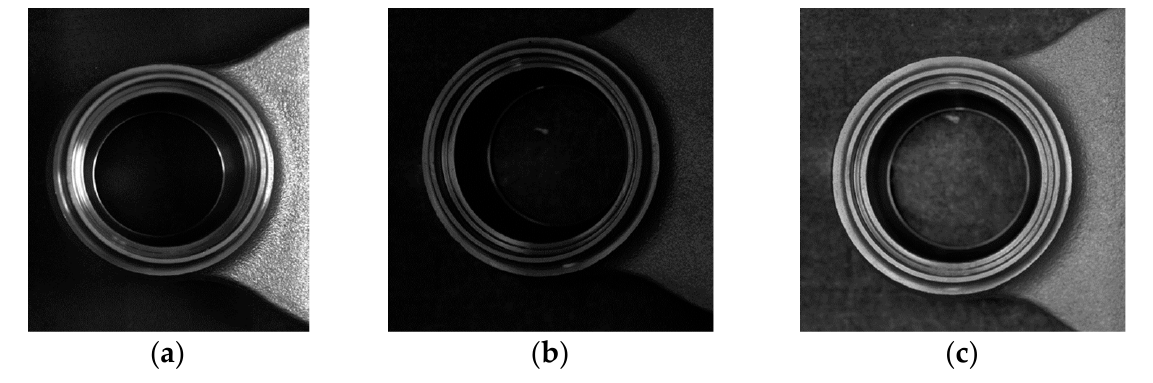
Figure 6. Illustration of light reflection issue of 3D ball joint socket object. ( a ) Light reflected, ( b ) before gamma correction, ( c ) gamma applied image.